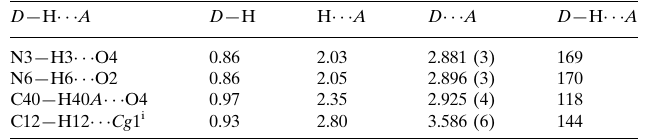
Hydrogen-bond geometry (A˚ , (cid:2)